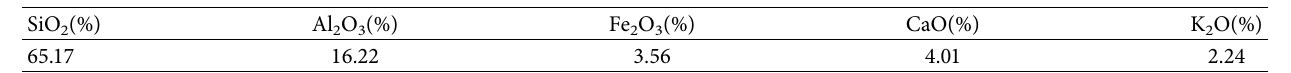
Table 2: Chemical compositions of the studied loess.